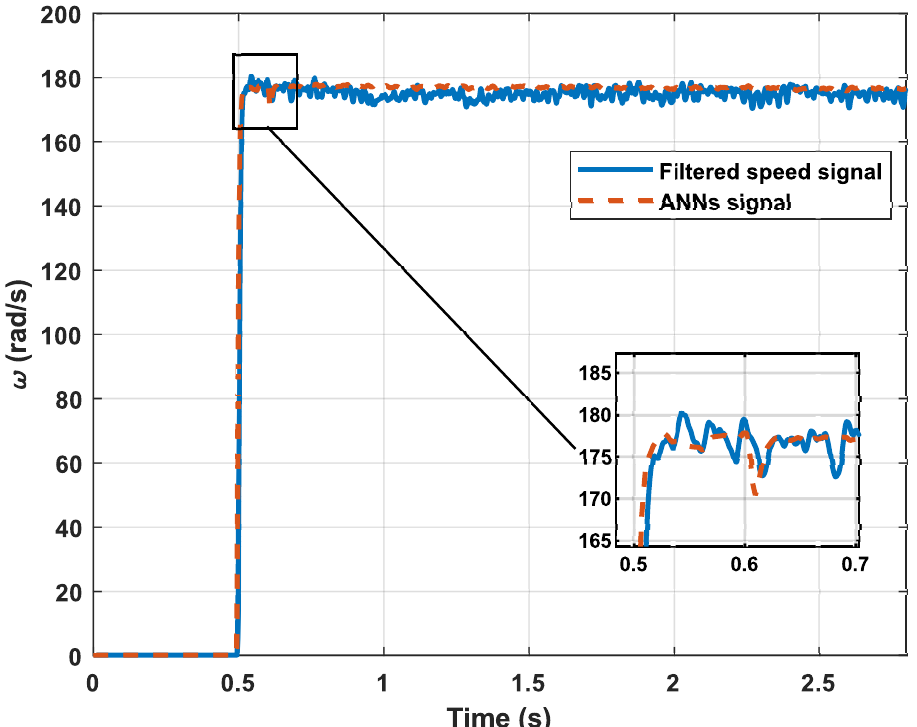
Figure 7. Simulation used for obtaining the variables of the step response.